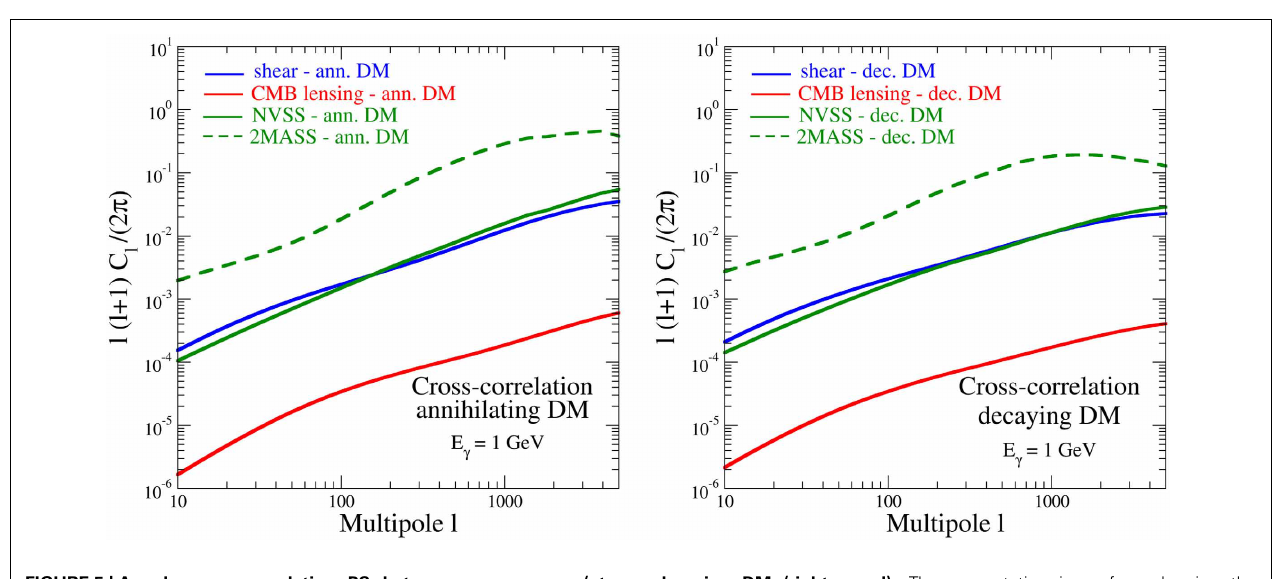
decaying DM (right panel). The computation is performed using the 3D PS models reported in Figure 2 and the window functions shown in Figure 3